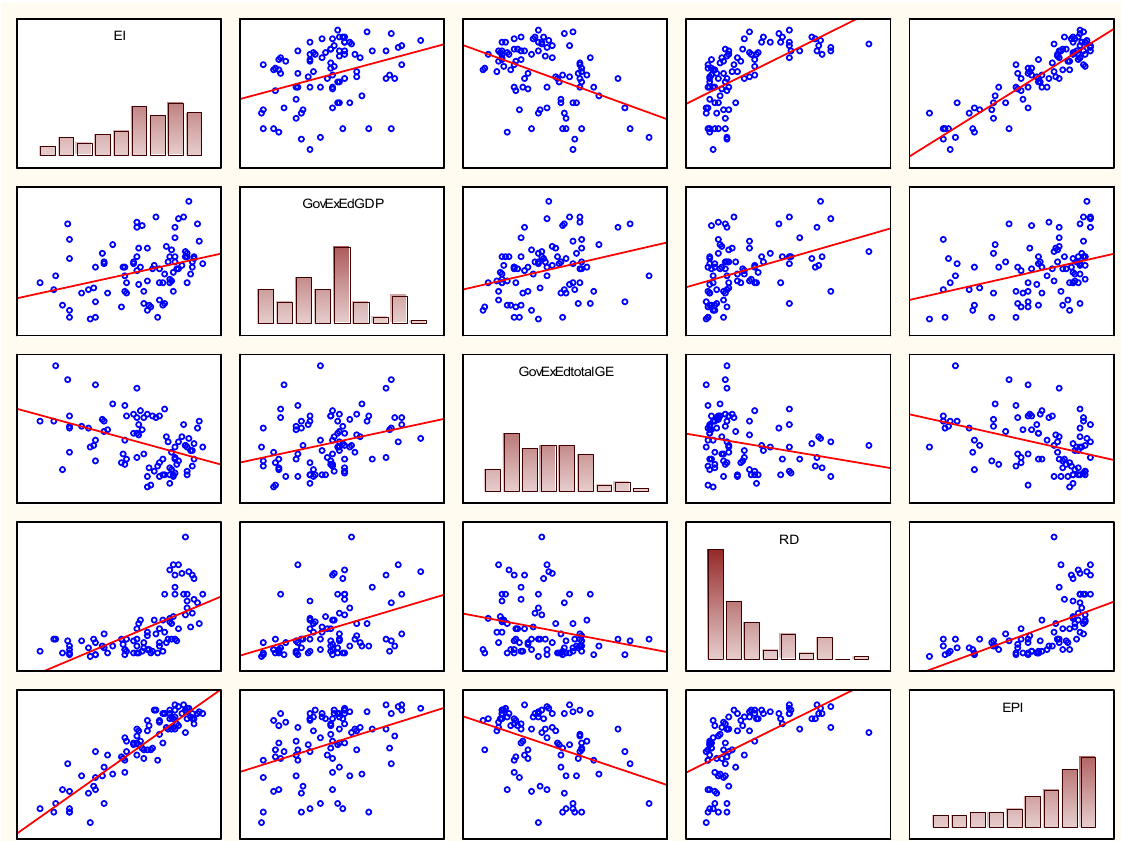
Fig. 1: The matrix of scattering diagrams between the dependent variable (EPI) and independent variables (EI, GovExEdGDP, GovExEdtotalGE, R&D)